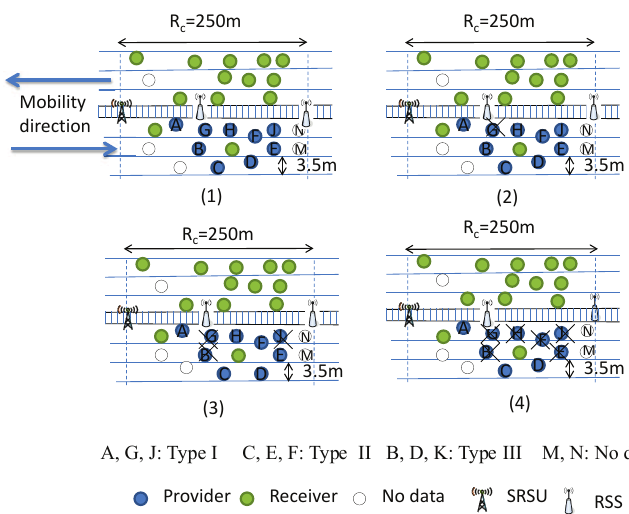
Figure 8. Selection of Leaders with different data types.